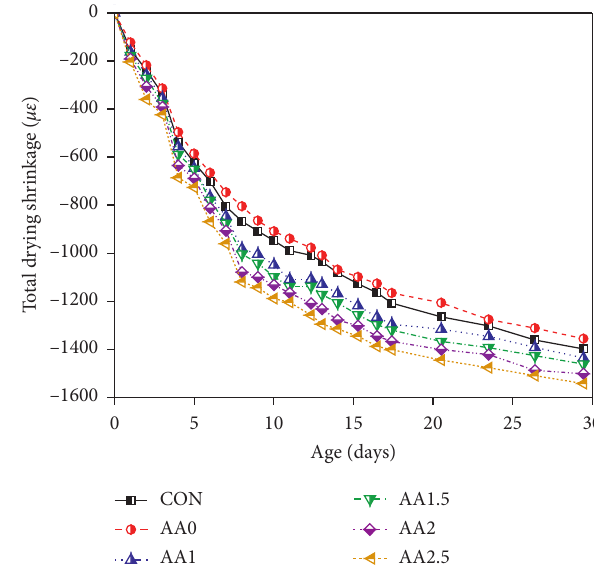
Figure 4: Dry shrinkage curve of each group.